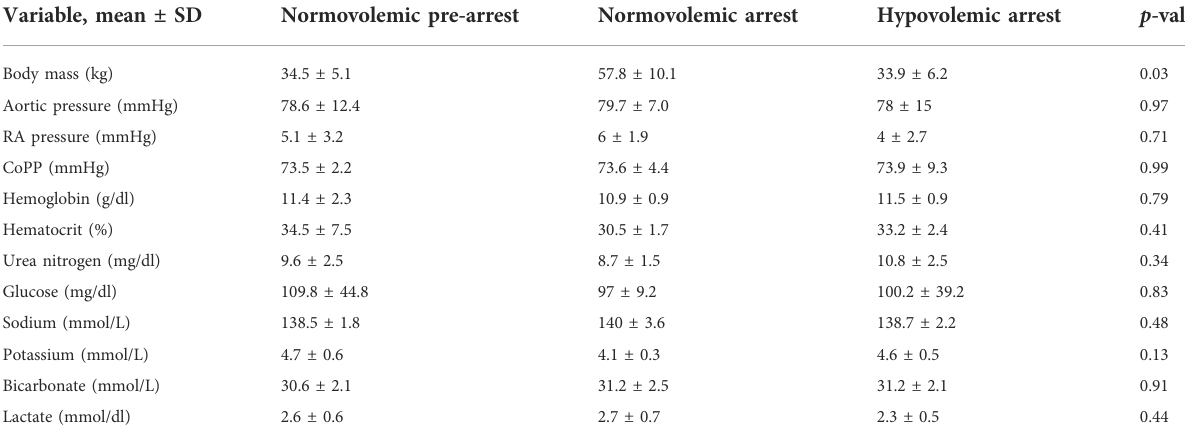
TABLE 1 Baseline characteristics of all groups.